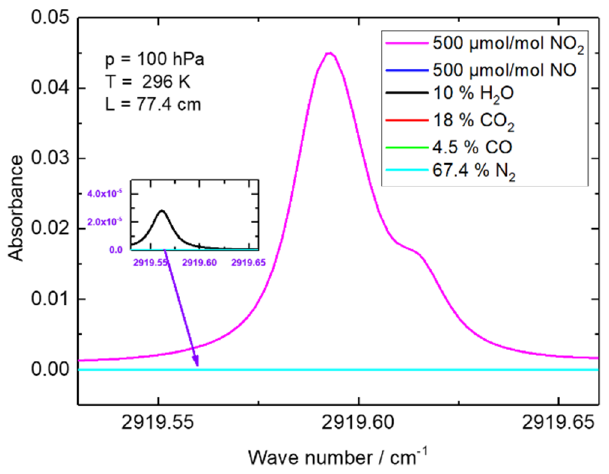
Figure 5. Simulation: NO 2 in exhaust gas matrix. Table 2. Summary of NO 2 OGS instrument capabilities.